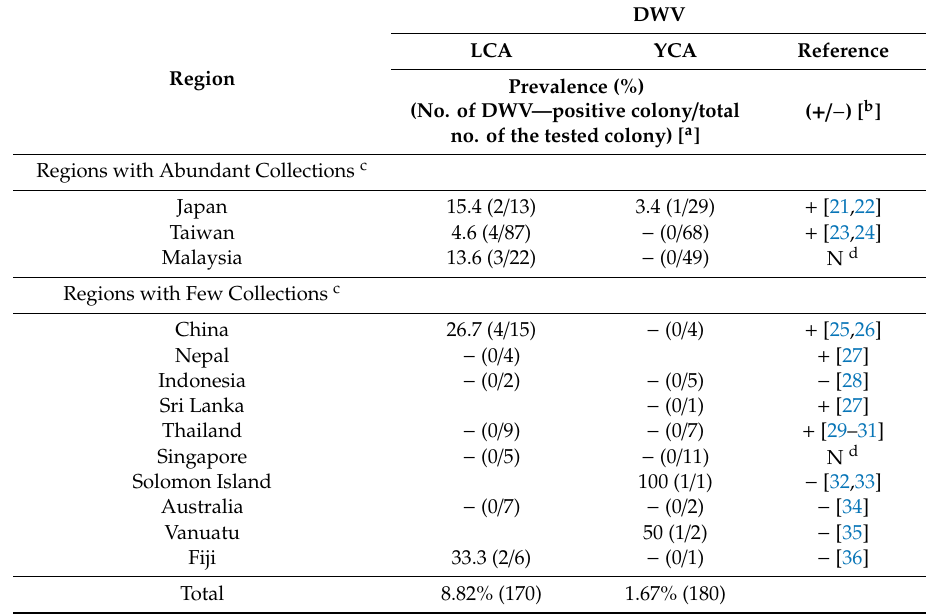
Table 1. Prevalence of deformed wing virus (DWV) in two invasive ant species, Paratrechina longicornis (longhorn crazy ant, LCA) and Anoplolepis gracilipes (yellow crazy ant, YCA), across the Asia–Pacific